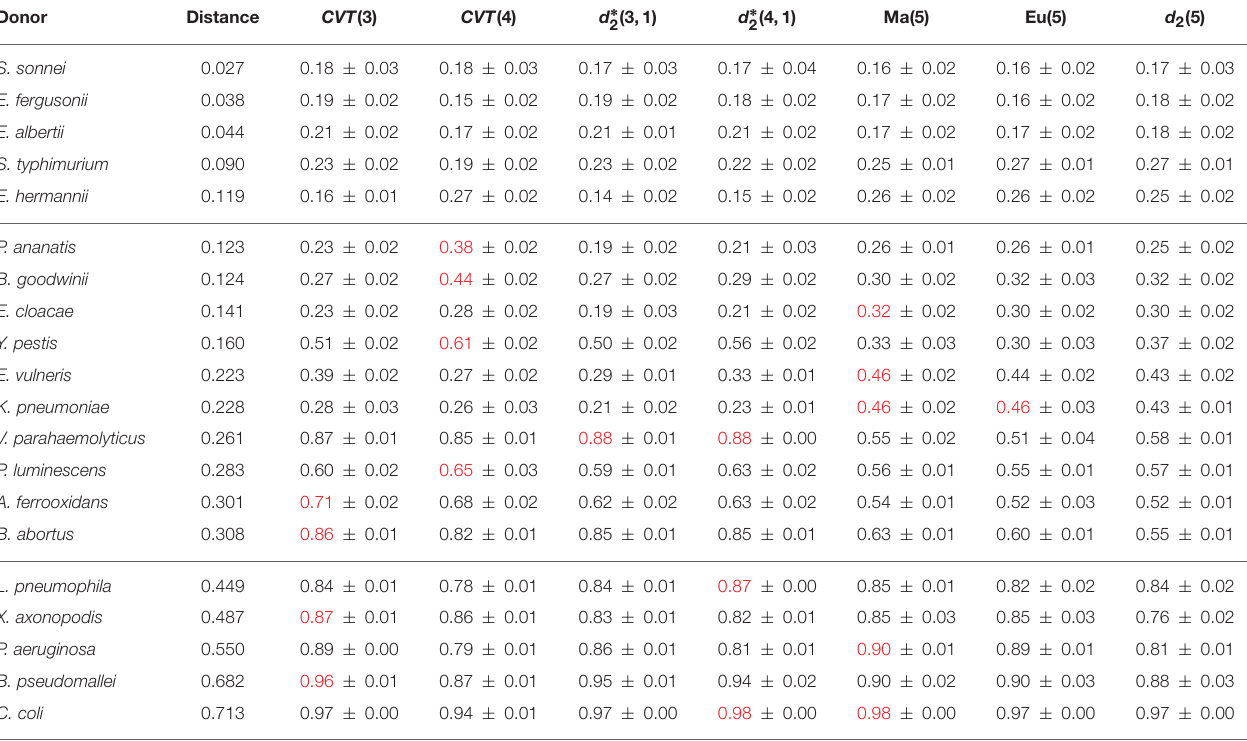
TABLE 2 | Performance of different alignment-free HGT detection methods over 20 artificial genomes with different donor genomes.